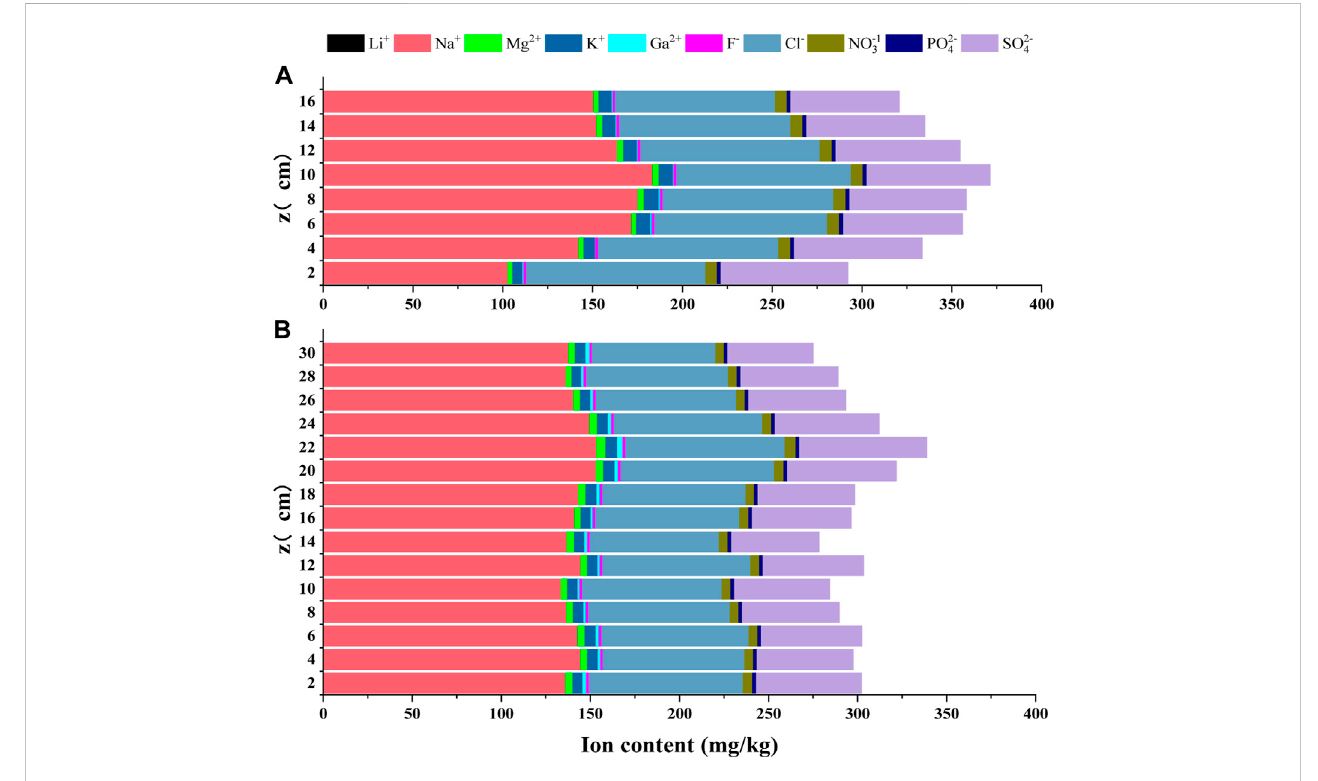
FIGURE 6 Vertical horizontal ion fl ux of